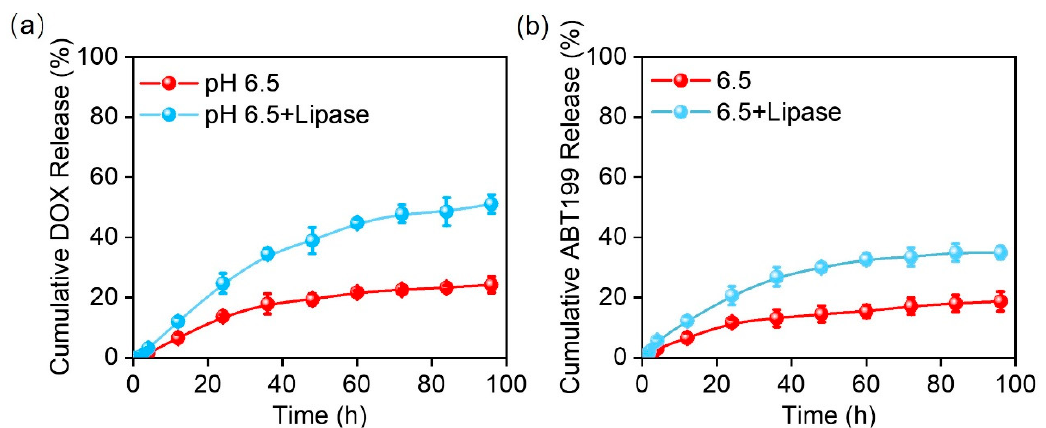
Figure 3. The cumulative release curves of ( a ) DOX and ( b ) ABT199 from the fabricated electrospun fibers in vitro.